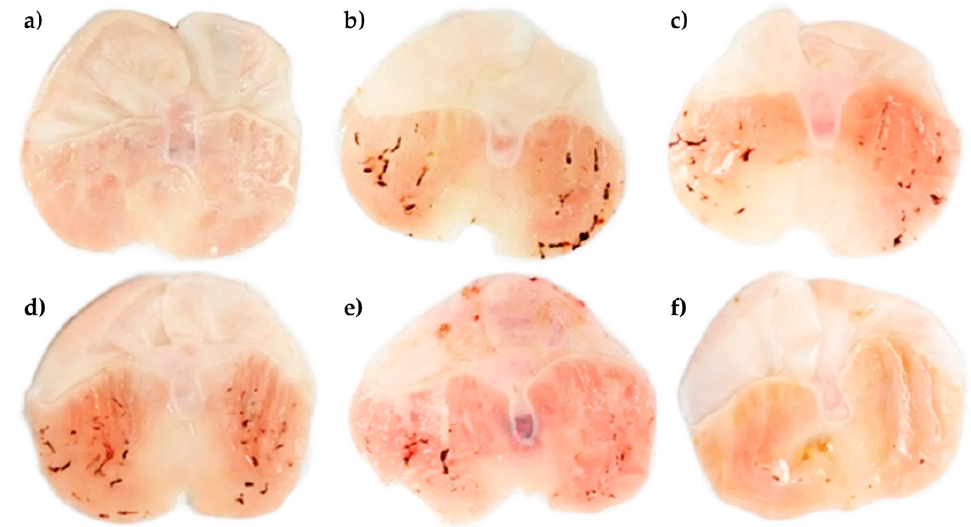
Figure 2. Macroscopic appearance of the gastric ulcer area of IND-induced in rat stomachs. ( a ) Control, normal appearance of the corpus region without gastric ulcers; ( b ) IND 40 mg/kg, necrotic ulcerations throughout the corpus; ( c ) CTD 100 mg/kg + IND 40 mg/kg, smaller number and size of necrotic ulcerations on the corpus; ( d ) PhyEx 100 mg/kg + IND 40 mg/kg, less protective effect against the development of gastric ulcers on the corpus; ( e ) PhyEx 200 mg/kg + IND 40 mg/kg, intermediate protective effect against the development of gastric ulcers on the corpus; ( f ) PhyEx 400 mg/kg IND 40 mg/kg, better protective effect against the development of gastric ulcers on the corpus. Table 1. Effect of PhyEx and CTD on ulcer parameters in rats with IND-induced ulcers. Groups